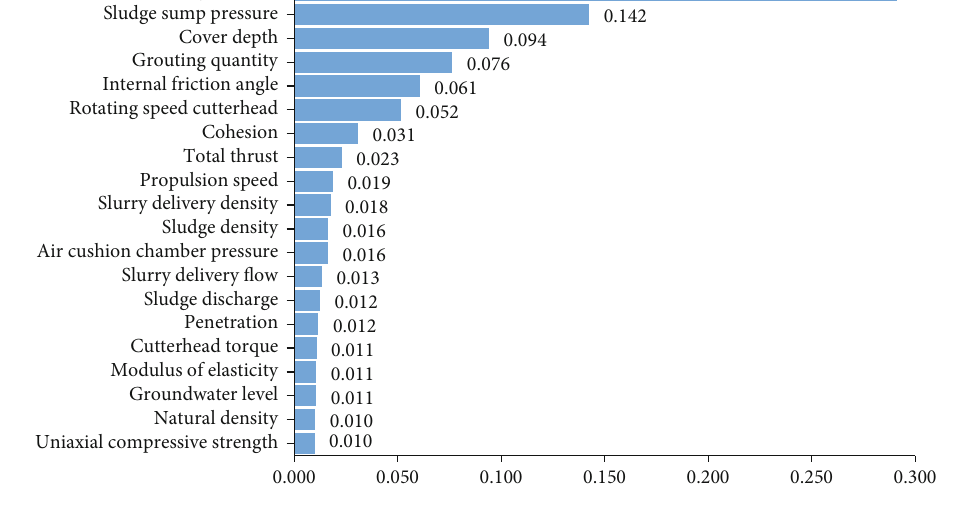
Figure 5: The VIM of key parameters.